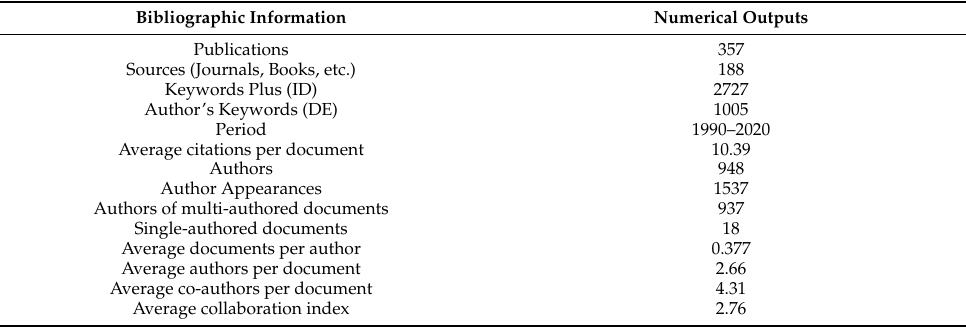
Table 1. Summarized bibliographic